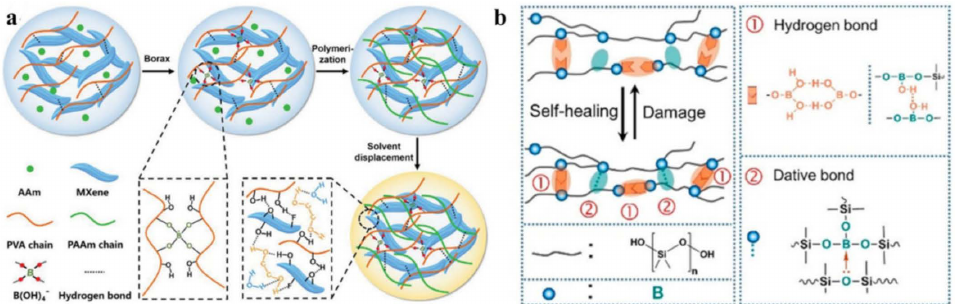
Figure 47. ( a ) Schematic illustration representation of SHP fabrication. Reproduced from [214] with permission from John Wiley and Sons. ( b ) Illustration of the polymer’s self-healing mechanism. Reprinted with permission from [215]. Copyright (2019) American Chemical